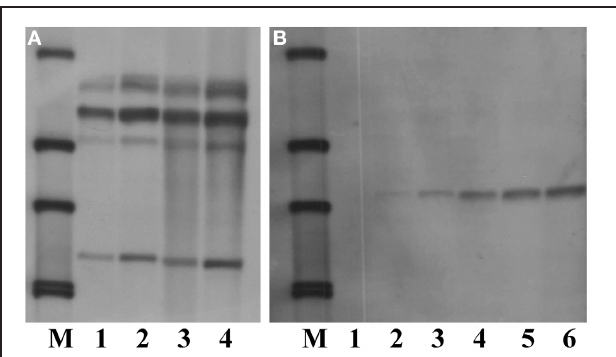
FIGURE 4 | Southern blot analysis showing different amounts of DNA used for digestion with Hin dIII and hybridized with the nptII probe according to Li et al. (2012). (A) DNA from transgenic Arabidopsis with the nptII gene, lane 1, 5 µ g; lane 2, 10 µ g; lane 3, 20 µ g; lane 4, 50 µ g. (B) DNA from transgenic crambe with the nptII gene, lane 1, 5 µ g; lane 2, 10 µ g; lane 3, 20 µ g; lane 4, 50 µ g; lane5, 80 µ g; lane 6, 100 µ g. M, DIG labeled molecular markers.